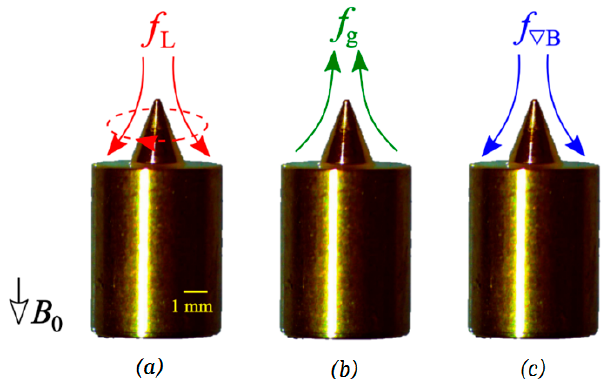
Figure 1. Photograph of the conically shaped iron cathode and the resulting fluid flows driven by the three forces in the system: ( a ) Lorentz force (primary and secondary flow indicated by dashed and solid lines, respectively), ( b ) buoyancy force, and ( c ) magnetic gradient force.